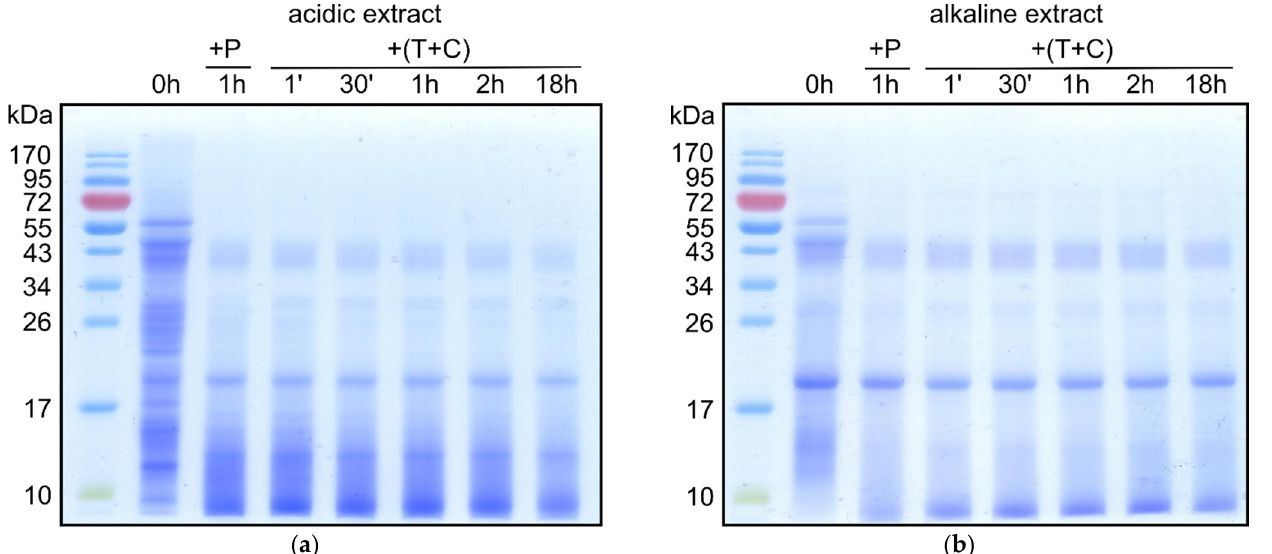
Figure 2. SDS-PAGE analyses of mealworm protein digests. The acidic ( a ) or alkaline ( b ) mealworm protein extract (0 h) was incubated first for 1 h with pepsin (P), and then with trypsin (T) and α -chymotrypsin (C) for different periods of time. Reaction mixtures were electrophoresed on 12% gels under reducing conditions. Lane 1 of each gel contains molecular mass standards. The gels were Coomassie stained.